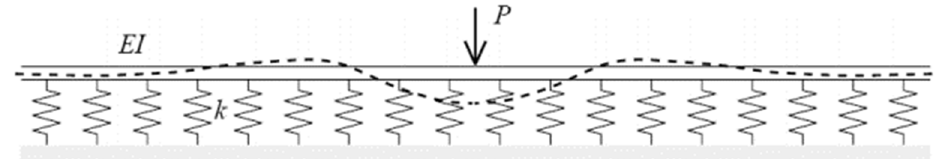
Figure 4. Beam on continuous elastic foundation.